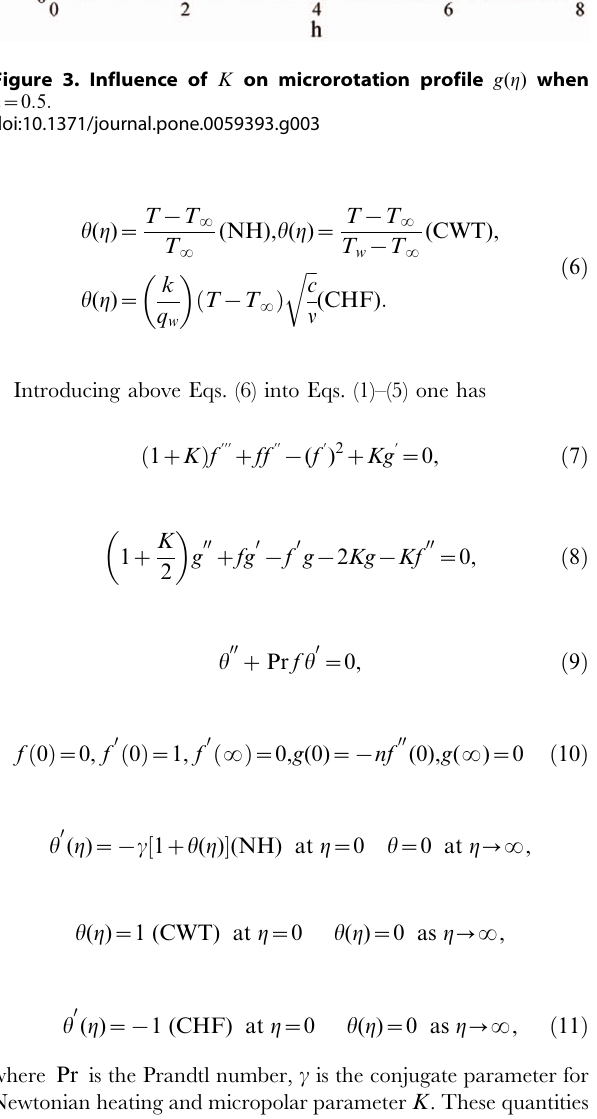
Figure 5. Influence of K on temperature profile h ( g ) when n ~ 0 : 5 :